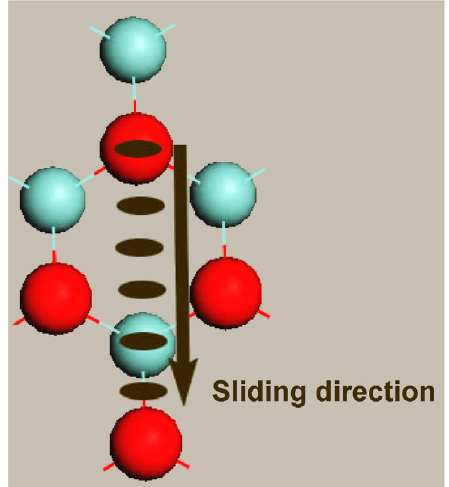
Schematic diagram (top view) showing the relative sliding between two MoO 2 (2 × 2 × 1) nanostructures. The ellipses indicate the relative positions and the arrow indicates the sliding direction. The red spheres represent the oxygen atoms and the light blue spheres represent the transition metal